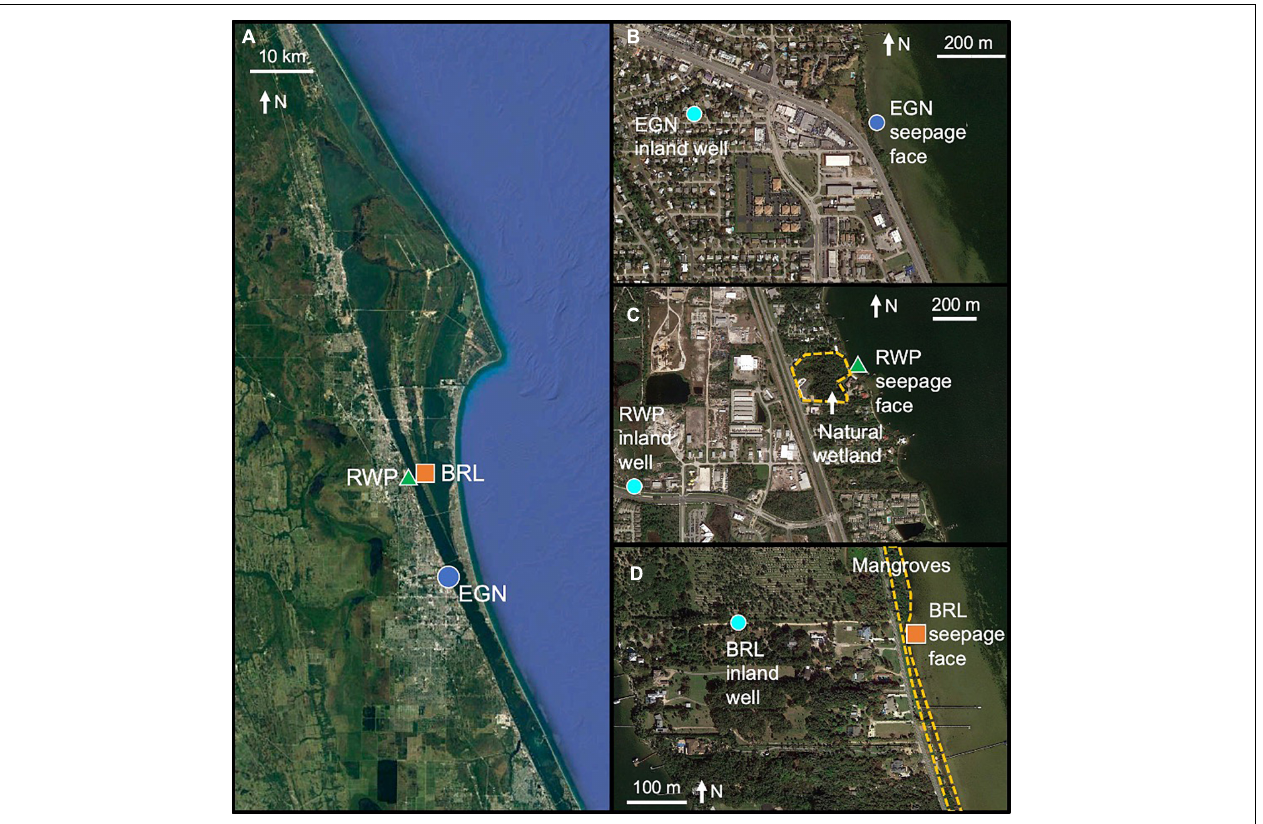
FIGURE 1 | Details of sampling locations at three sites of groundwater seepage to (A) Indian River Lagoon including (B) Eau Gallie North (EGN), (C) Riverwalk Park (RWP), and (D) Banana River Lagoon (BRL) sites. Locations of inland wells are shown in cyan circles. The location of natural wetlands (RWP, panel C ) and mangroves (BRL, panel D ) are shown with dashed gold lines.© Google